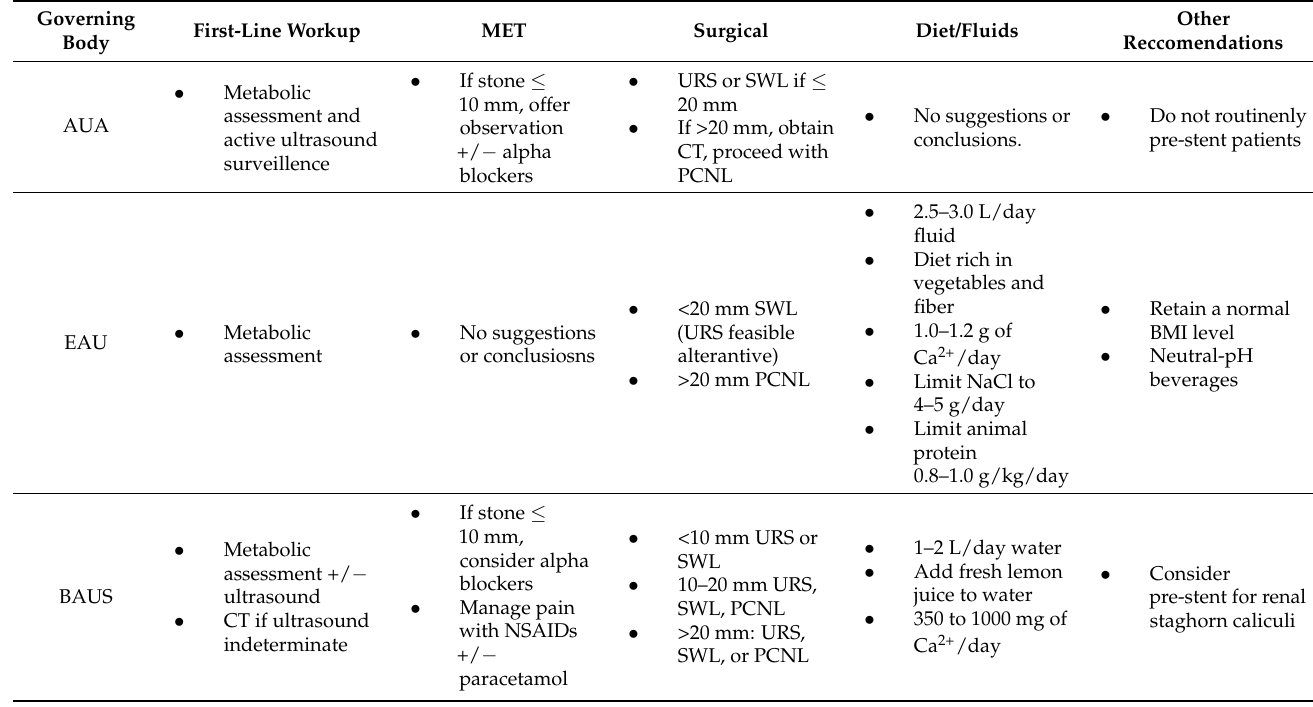
Table 4. Comparison of international governing bodies of urology for pediatric kidney